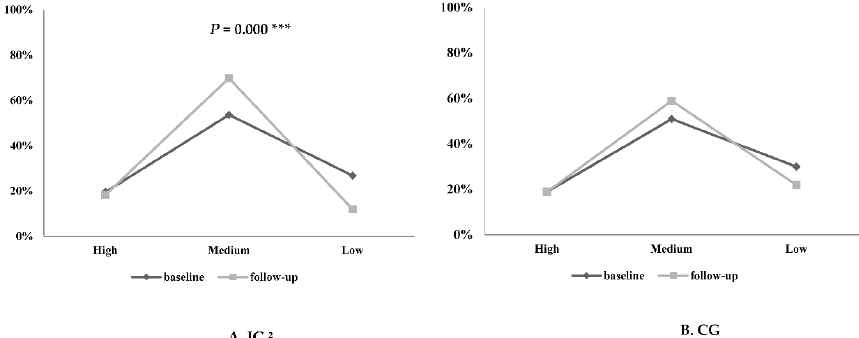
Figure 2. Changes in the nutrition quotient (NQ) grade of the preschoolers participating in the Mission X program according to their group. 2 IG: Intervention group, CG: control group. ***: p < 0.001 by McNemar test.